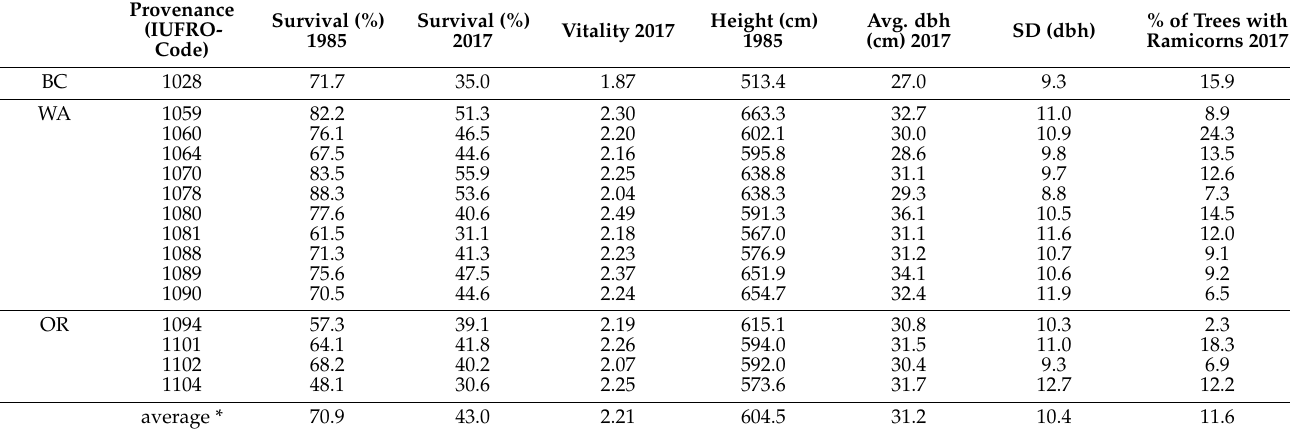
Table 2. Performance of 15 Douglas-fir provenances originating from the west coast of North America (British Columbia (BC), Washington (WA), and Oregon (OR)) and planted in the Slovenian provenance trial. Measurements on survival, ramicorns, vitality, and diameters were conducted on all trees per provenance. * Arithmetic means from ordinal estimates were calculated only for the sake of easier representation and